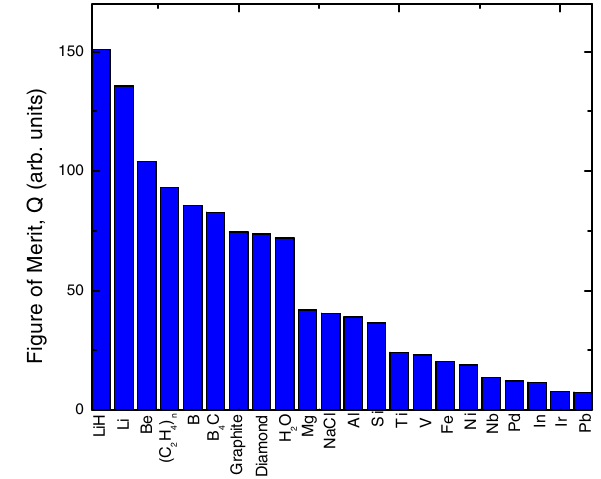
FIG. 4. Ranking of different materials based on their expected performance. Our figure of merit Q is the ratio between the ionization term dE μ =ds and the scattering term 1 =L R . Clearly, higher Q implies better